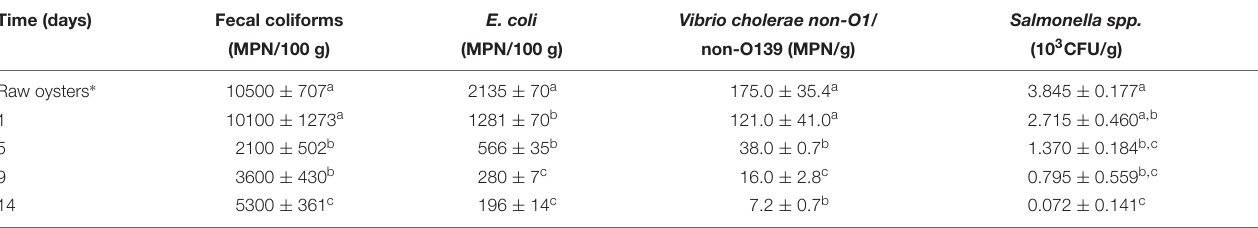
TABLE 5 | Survival of Fecal coliforms, Escherichia coli , Vibrio cholerae , and Salmonella spp. in non-ozonated American oyster ( Crassostrea virginica ) superchilled stored at − 1 ◦ C. Time (days) Fecal coliforms